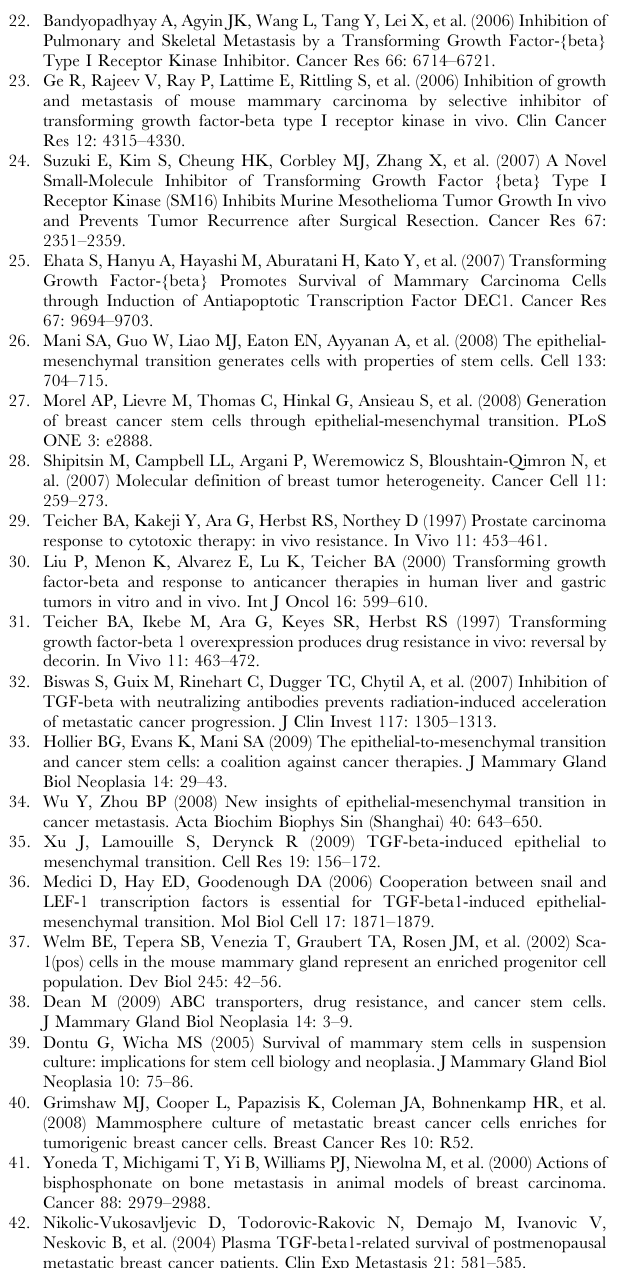
Figure S4 Prolonged treatment of 4T1 cells with TGF b 1 enhanced formation of mammospheres. 4T1 cells were treated with 0.05 or 0.1 ng/ml of TGF b 1 for 12 days with medium change every alternate day. Cells were harvested and passed through a 40 m m nylon membrane to obtain a single